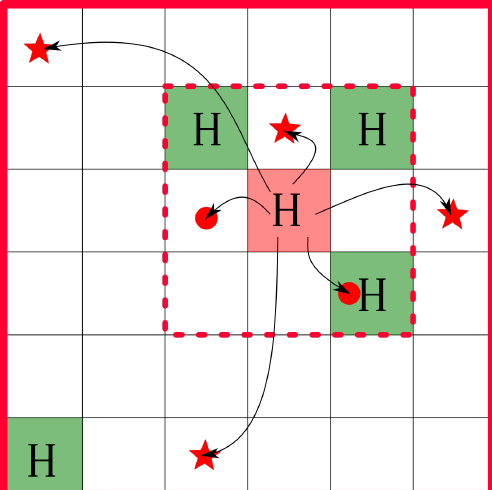
Figure SI.5. Local and global dispersal of offspring from the host in the red cell over the landscape. Local dis- persal (red circles) occurs only within the neighborhood of the host (red dashed square) while global dispersal (red stars) occurs over the entire landscape (red plain square). The host has a dispersal trait ε = 2 / 3 and it disperses 6 offspring: 4 globally (red stars) and 2 locally (red